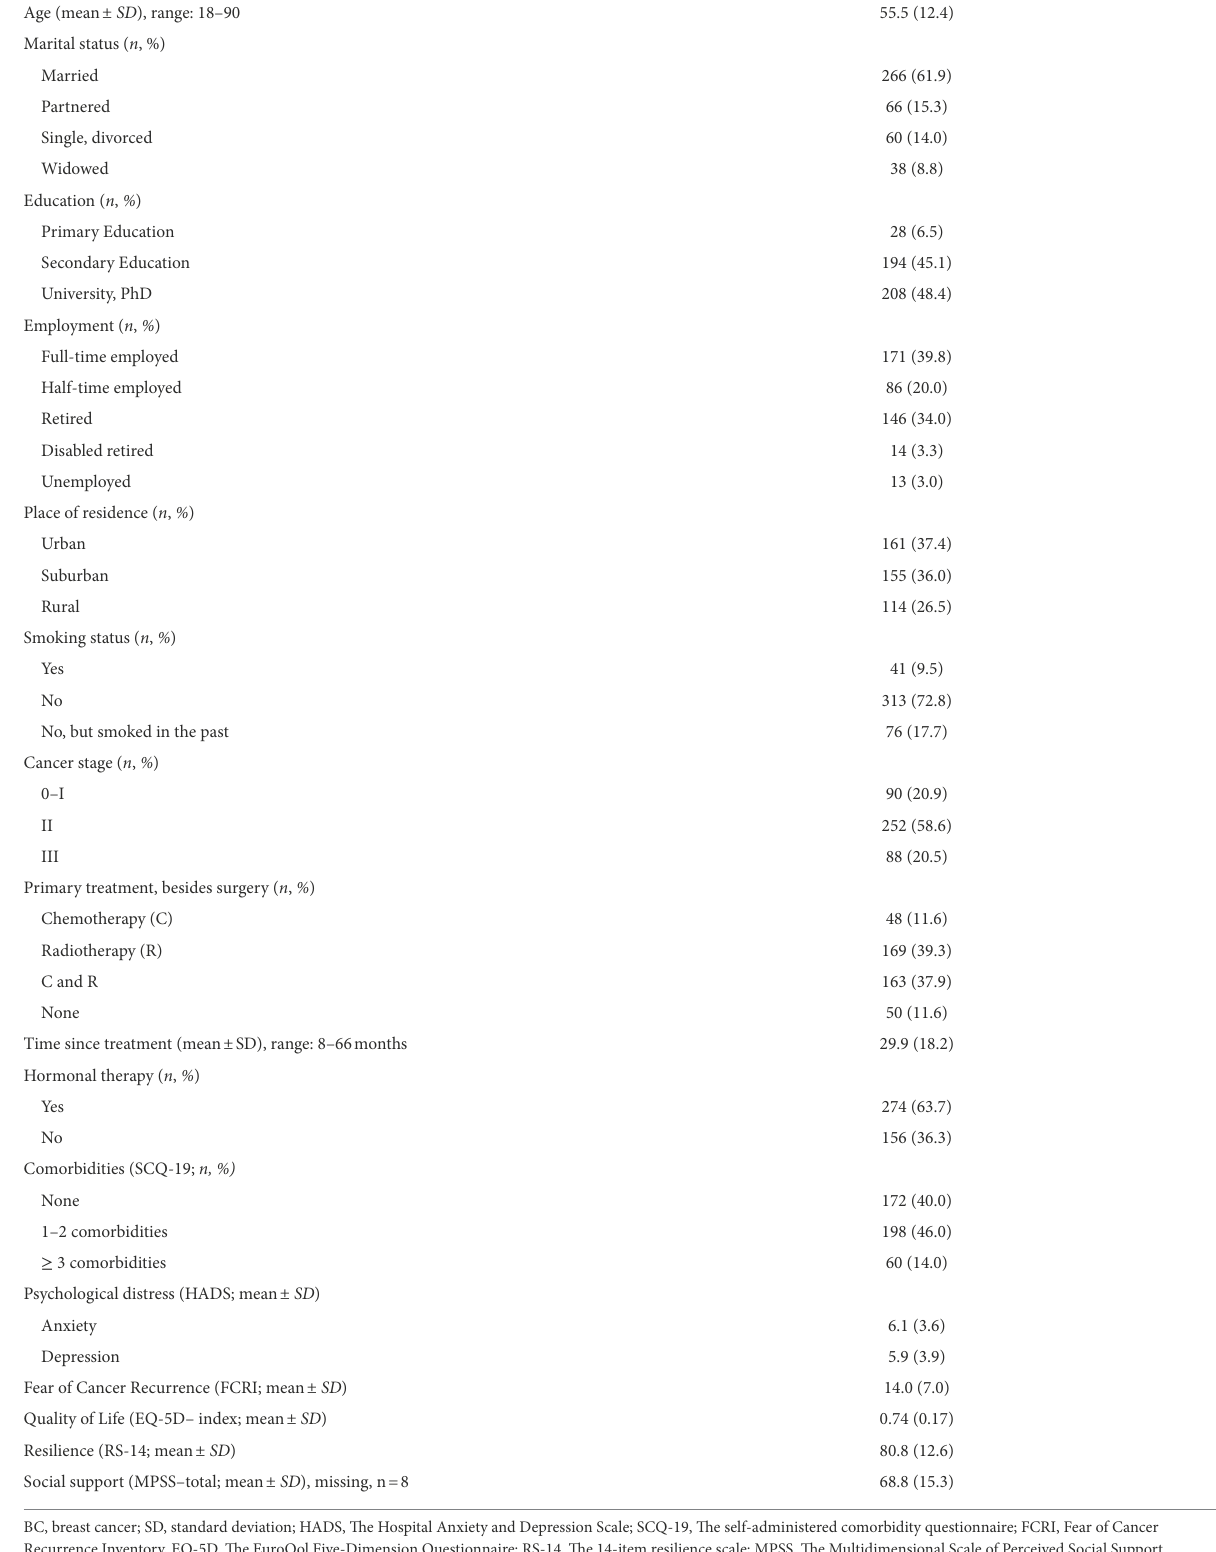
TABLE 1 Sociodemographic, disease and treatment-related, and psychological variables ( N = 430). Characteristics Sample of BC